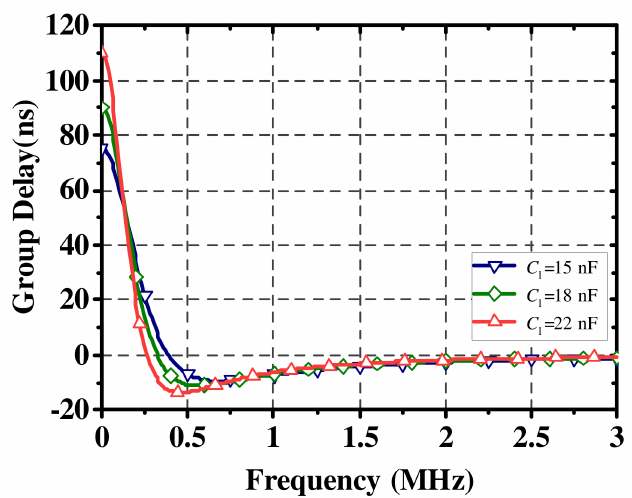
Figure 5. High-pass negative group delay with different